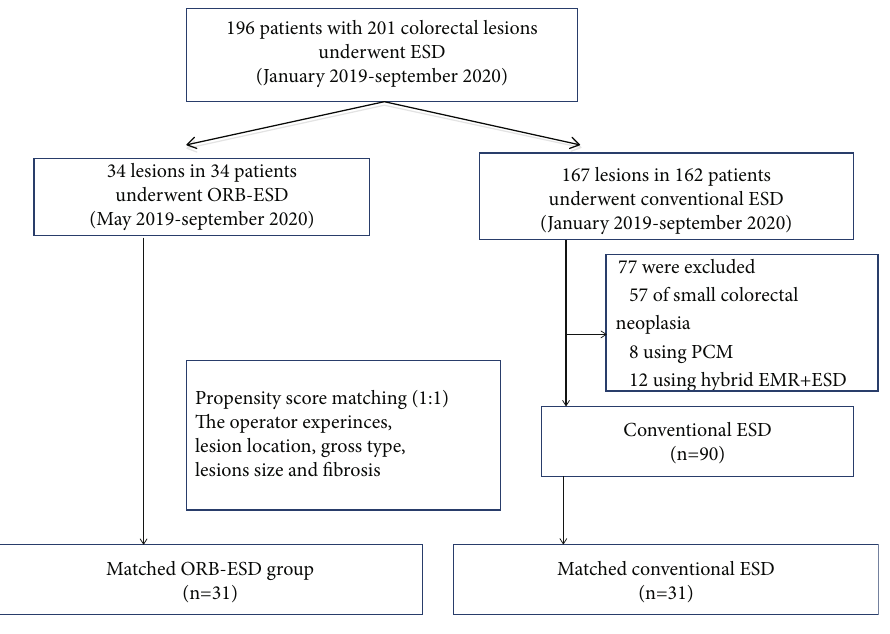
Figure 1: Study fl owchart.